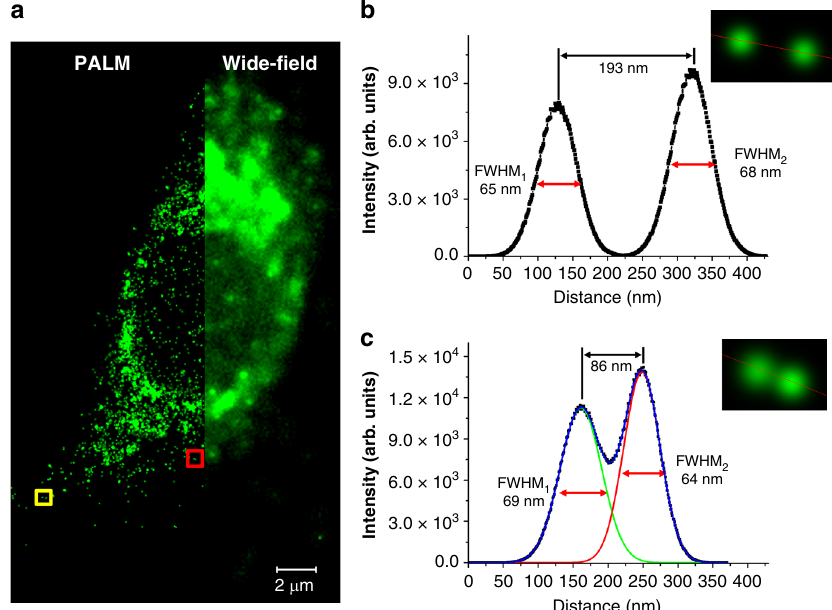
Fig. 8 Super-resolution microscopic imaging. a Super-resolved PALM (left) and conventional wide- fi eld (right) images of the RAW264.7 cell which is magni fi ed a thousand times. b , c Fluorescence intensity cross-sectional pro fi les of two pairs of neighboring PCL nanoparticles in the square region in ( a ) (yellow square for ( b ) and red square for ( c ),